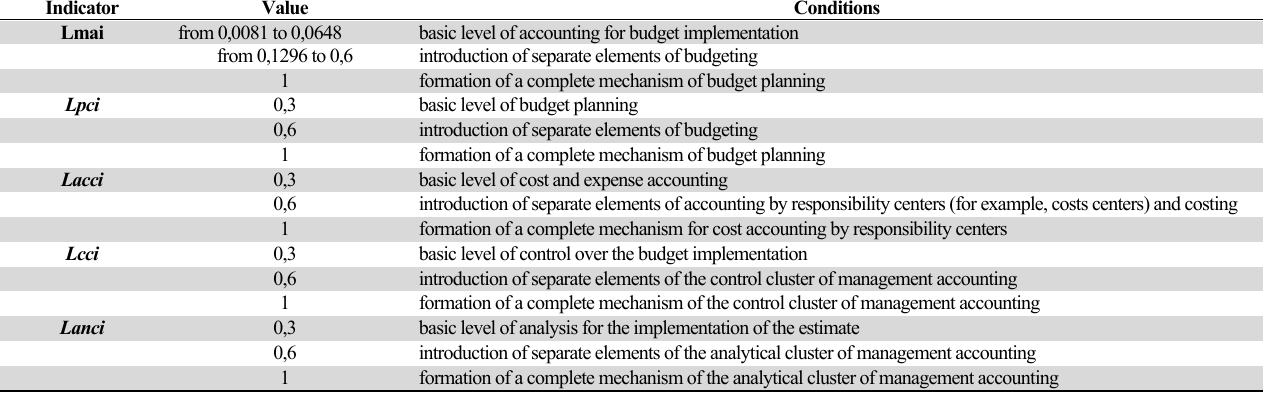
The value of indicators of the level of management accounting introduction in the the activities of SIHE in the context of conditions Indicator